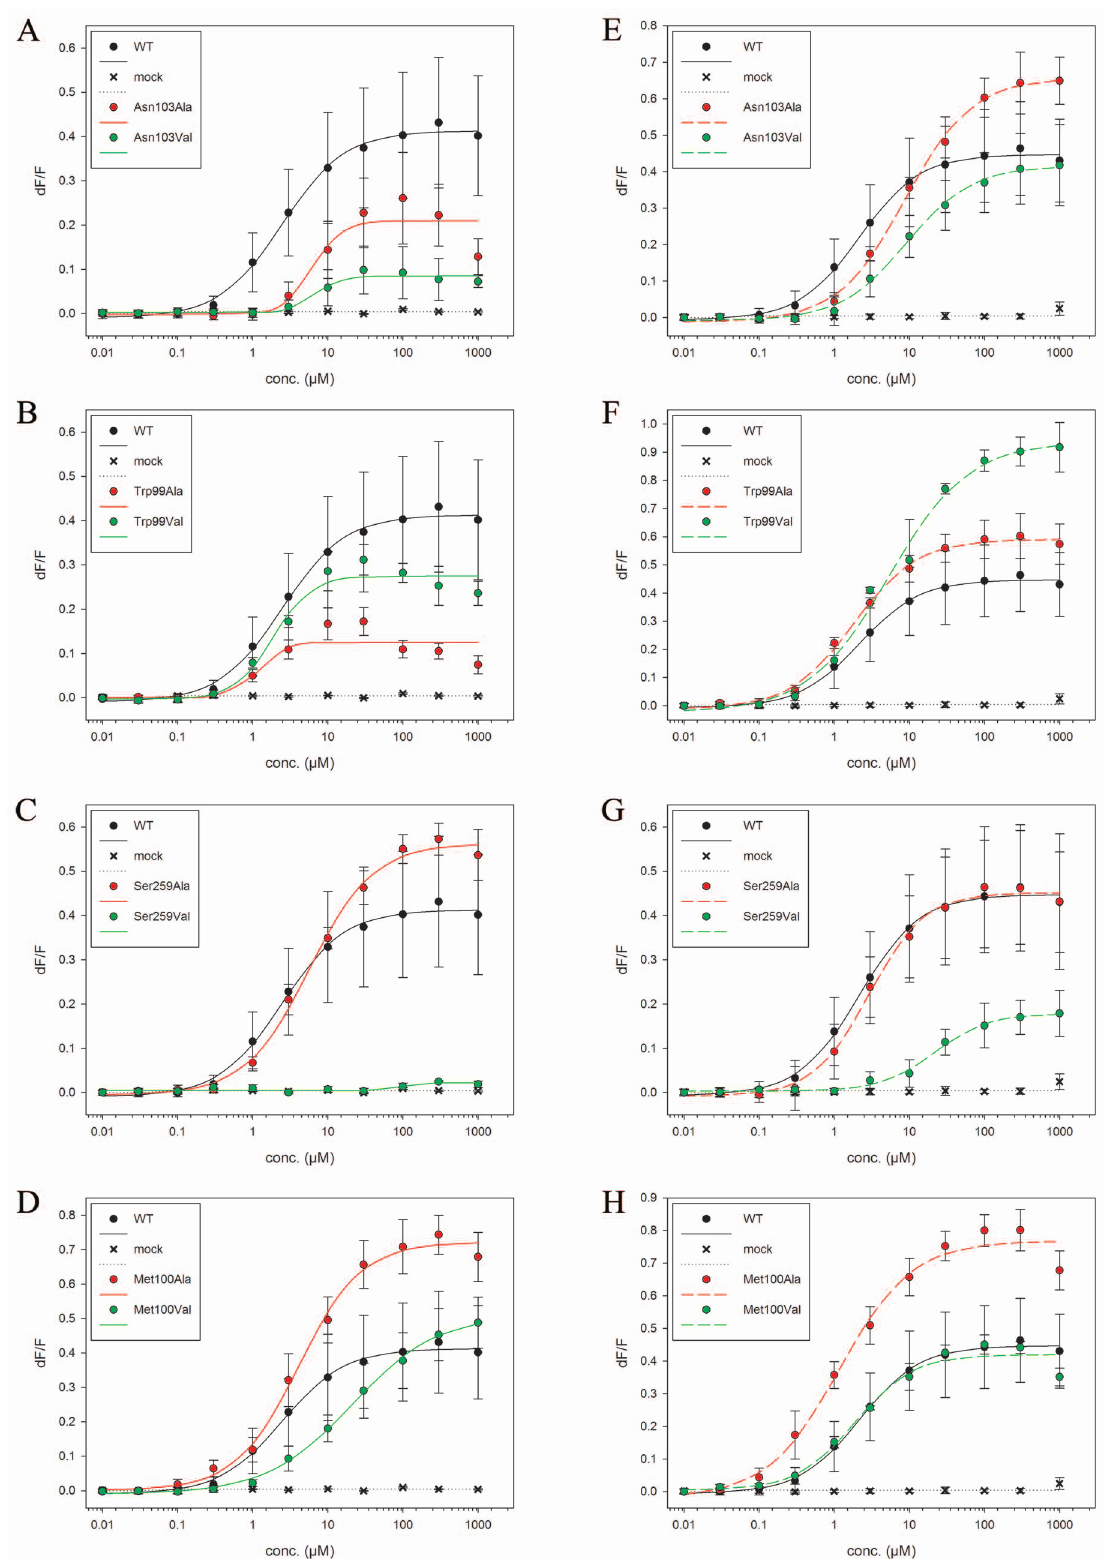
Figure 5. Dose-response curves. Dose-response curves of TAS2R38 wild type and mutants after stimulation with increasing PTC and PROP concentrations (0 to 1000 m M). Each point corresponds to the mean 6 standard deviation. The mean is calculated from at least three independent experiments. A–D) PTC application, E–H) PROP application.